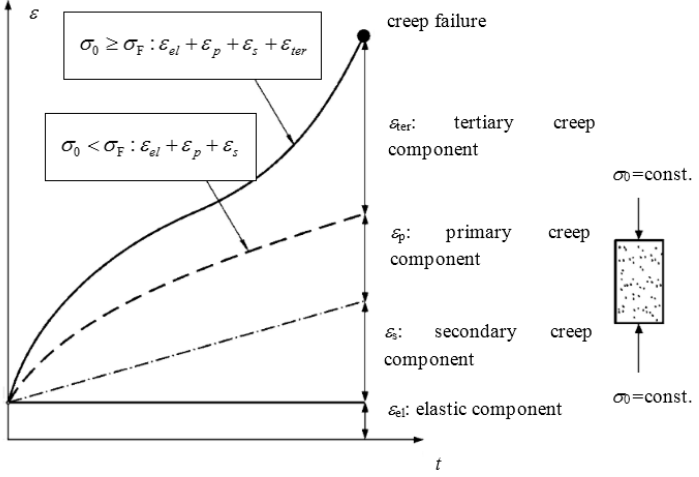
Figure 6. Primary, secondary and tertiary creep in uniaxial test (after Tomanovic [54]).